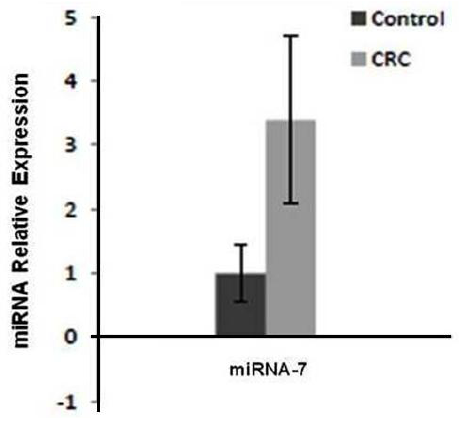
Fig. 2. Expression level of miRNA-7 in plasma of colorectal cancer patients: Real time RT-PCR was used to analyze the expression level of miRNA-7 in plasma samples. miRNA-7 was significantly overexpressed by 3.4 fold in CRC patients relative to normal group